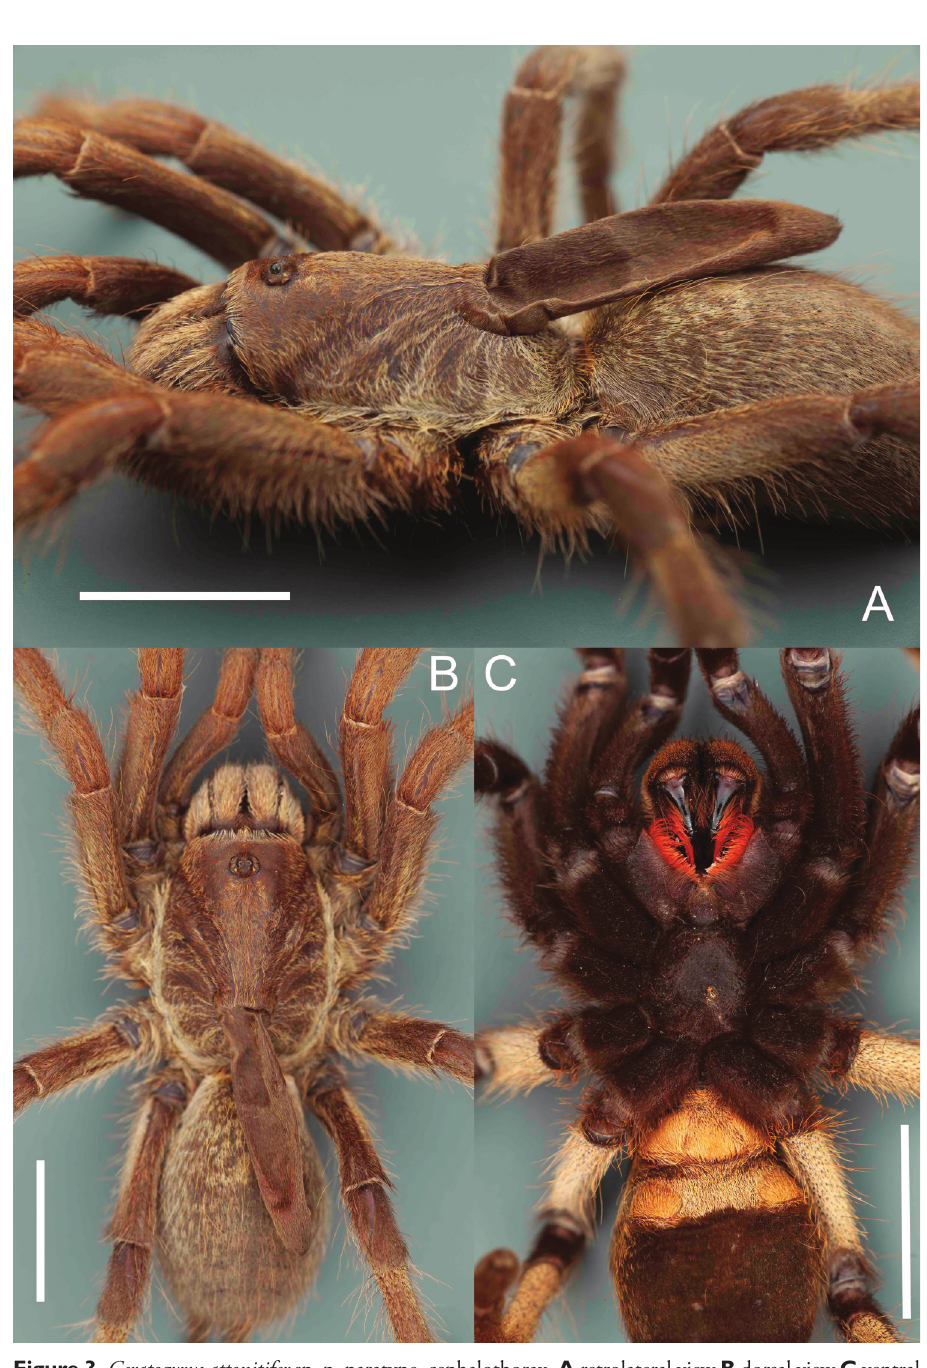
Figure 3. Ceratogyrus attonitifer sp. n. paratype, cephalothorax. A retrolateral view B dorsal view C ventral view. Scale bar: 10mm ( A